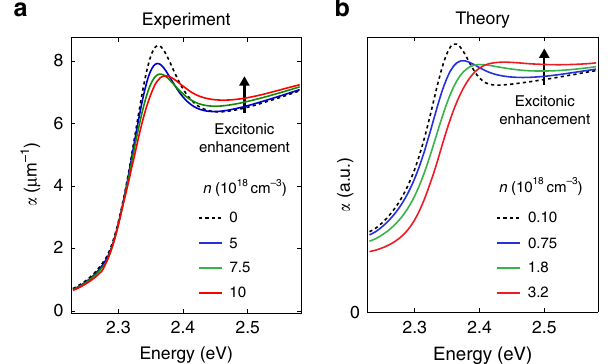
Fig. 4 Comparison between experimental and theoretical absorption spectra. a Experimental absorption spectrum of CH 3 NH 3 PbBr 3 single crystals for the excitation densities of 5, 7.5 and 10 × 10 18 cm − 3 at 1 ps. Similar trends can be observed at any time delay between 500 fs and several ps. b Theoretical absorption spectra of CH 3 NH 3 PbBr 3 in the presence of increasing carrier densities, as calculated with the SBE. The black arrow indicates the excitonic enhancement of the above-gap absorption associated with the presence of e – h correlations in the highly photoexcited material. In both cases, the Wannier bound exciton peak persists above n M